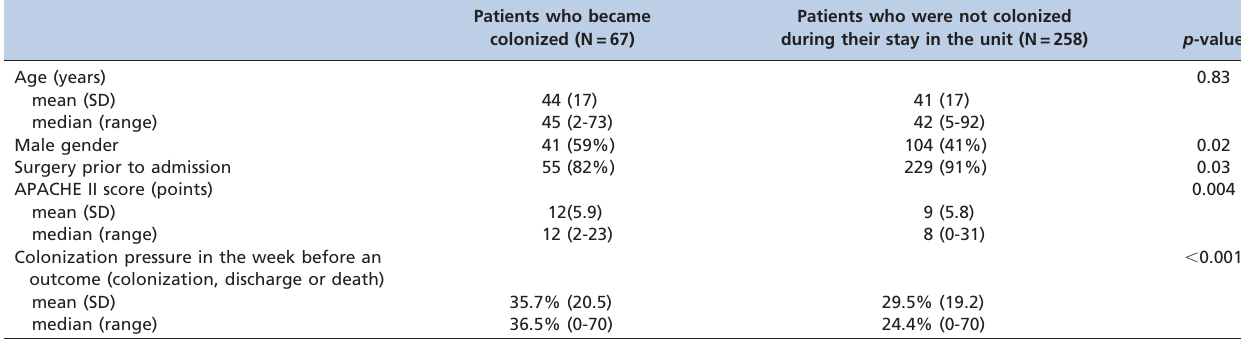
Table 3 - Bivariate analysis of factors potentially associated with colonization by MRAC and CRPA in a neurology intensive care unit.